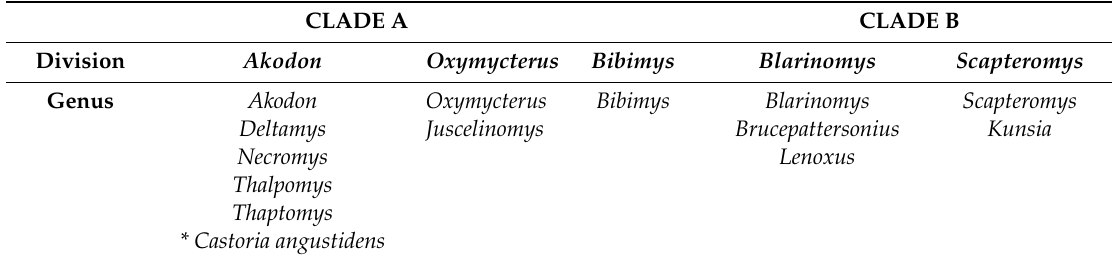
Table 1. Akodontini tribe divisions and major clades recovered by the strict consensus tree from Maximum Parsimony analysis performed by D’El í a [27].